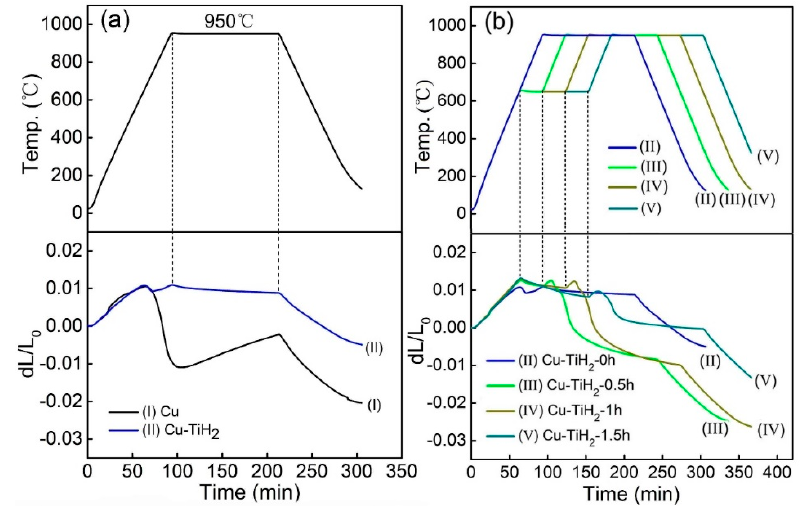
Figure 5. Dilatometry curves and corresponding temperature profiles of ( a ) pure Cu and Cu-0.5 wt.% TiH 2 samples heated to 950 °C without isothermal treatment, and ( b ) Cu-0.5 wt.% TiH 2 samples isothermally-treated at 650 °C for different time before being heated to 950 °C (dL/L 0 is the ratio of the change in the length of the sample in the heating to its original length). Table 2. A summary of densities, oxygen contents and expansion peak temperatures of the